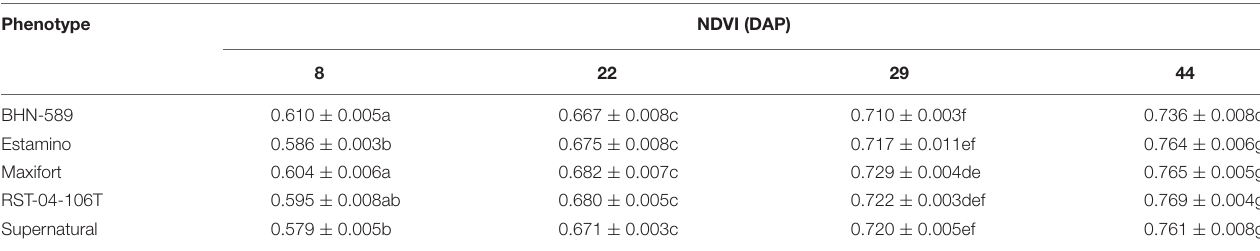
TABLE 4 | Normalized Difference Vegetation Index (NDVI) of four grafted rootstocks (Estamino, Maxifort, RST-04-106-T, and Supernatural) and one cultivar (BHN-589) grown under field conditions and measured at 8, 22, 29, and 44 days after planting (DAP).